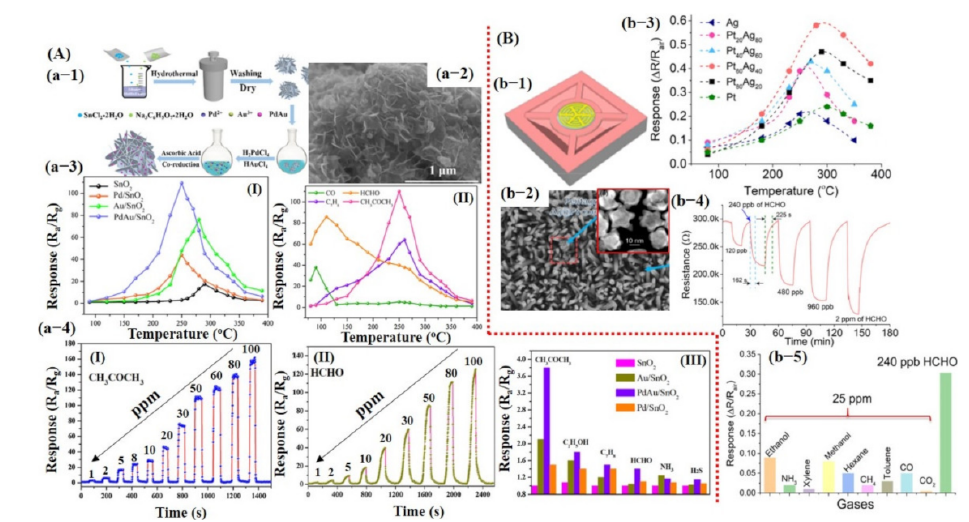
Figure 9. Metal oxide-based gas sensors: ( A ) Pd/Au NPs decorated on the SnO 2 nanosheets for temperature-dependent acetone and HCHO detection: (a-1) Synthesis process of Pd/Au NPs